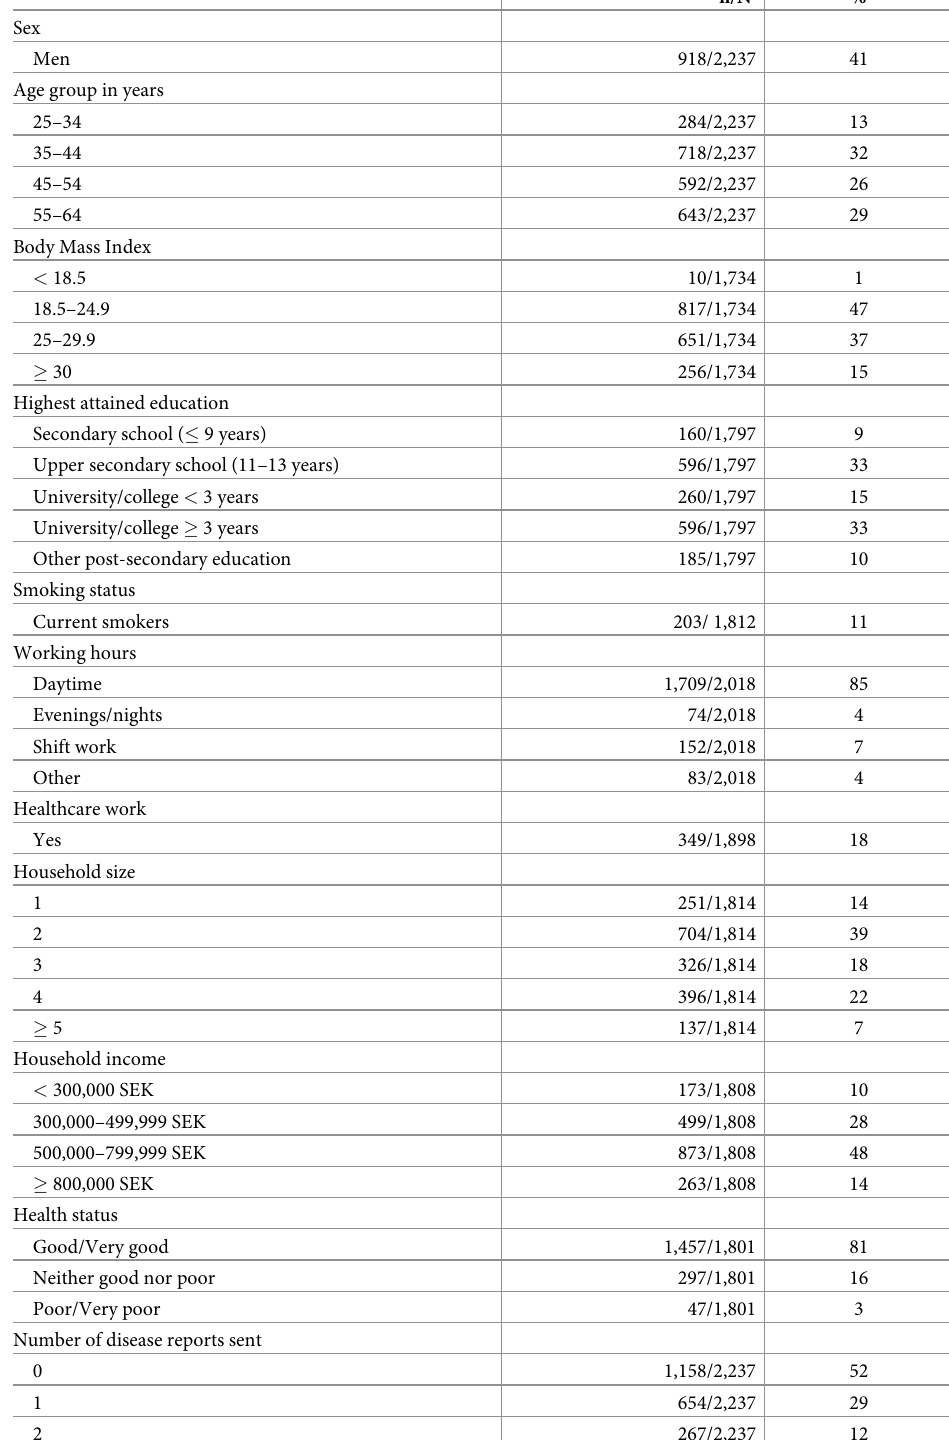
Table 2. Demographic and clinical characteristics of the 2,237 participants enrolled in the cohort for the study of work-related risk factors for transmission of viral infections (SWEDE-I), Sweden, August 2011–May